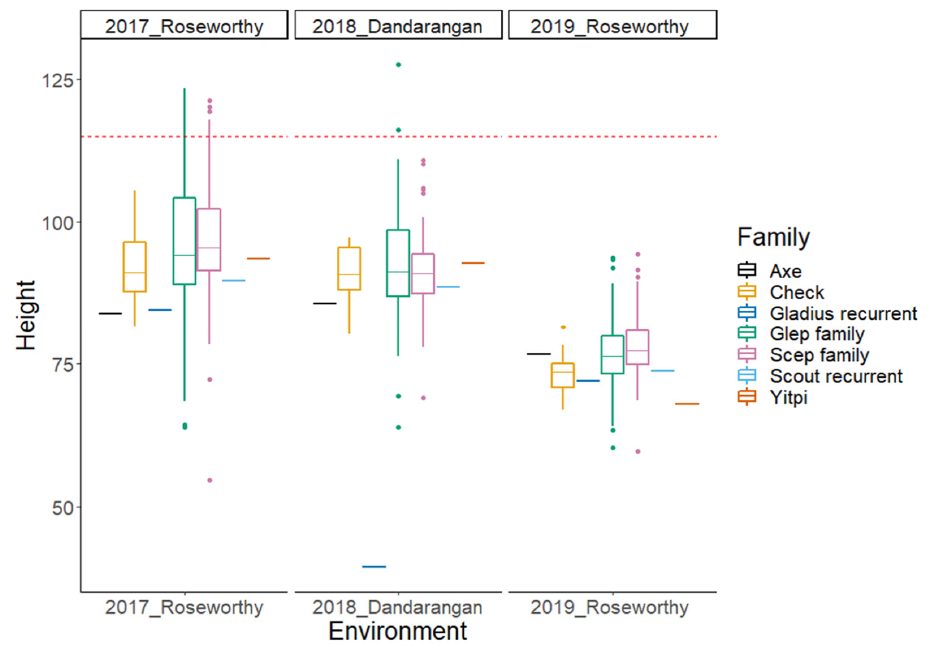
Figure 2. Boxplots of plant height BLUPs for the subset of the Wheat Hub NAM population and the check varieties in three different environments. The NAM subset population is separated into Gladius and Scout families. The horizontal dotted line represents the selection threshold of 115 cm for plant